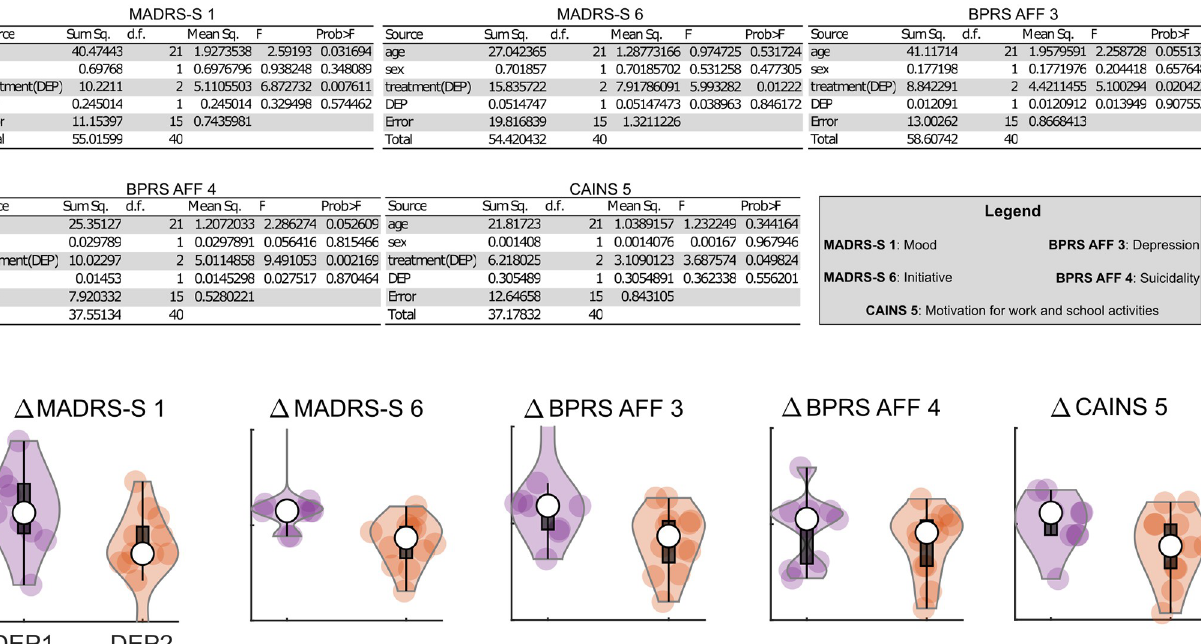
PLOS Computational Biology | https://doi.org/10.1371/journal.pcbi.1010958 March 6,